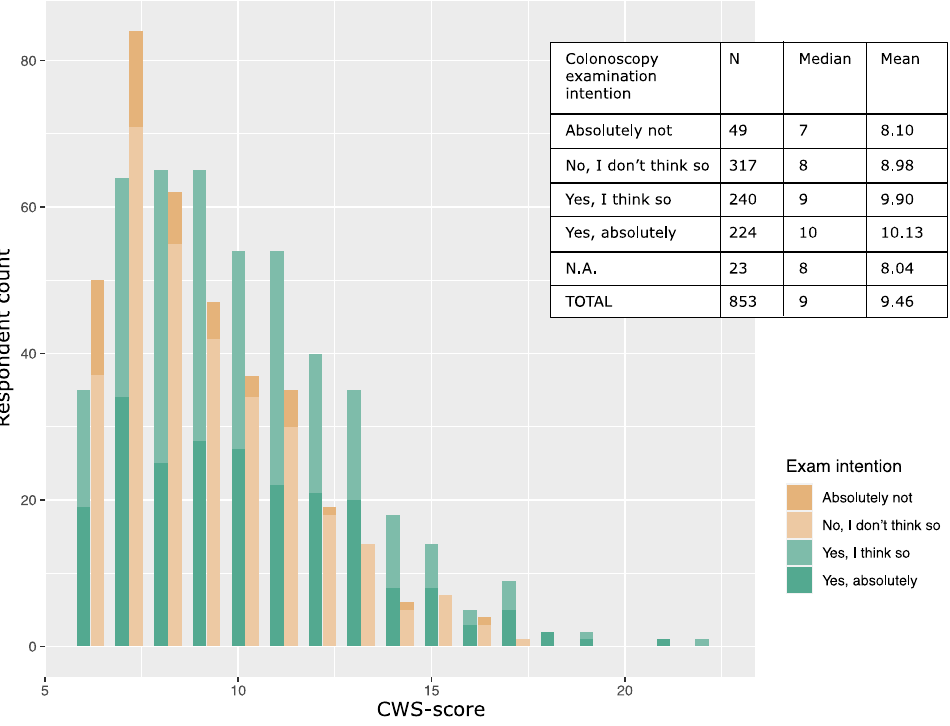
Figure 2. Distribution of cancer worry score grouped by intention to undergo a colonoscopy. Six-item CWS scores among respondents with intention to undergo a colonoscopy (green bars, n = 464, median 10, mean 10.01) and respondents without intention to undergo a colonoscopy (brown bars, n = 366, median 8, mean 8.86) in the scenario of having a 5% lifetime colorectal cancer risk. The proportion of respondents who intended to undergo a colonoscopy increased with the increasing level of hypothetical colorectal cancer risk (Chi2 test, p < 0.001). This trend remained when the data were stratified into high and low cancer worry subgroups (Figure 3).